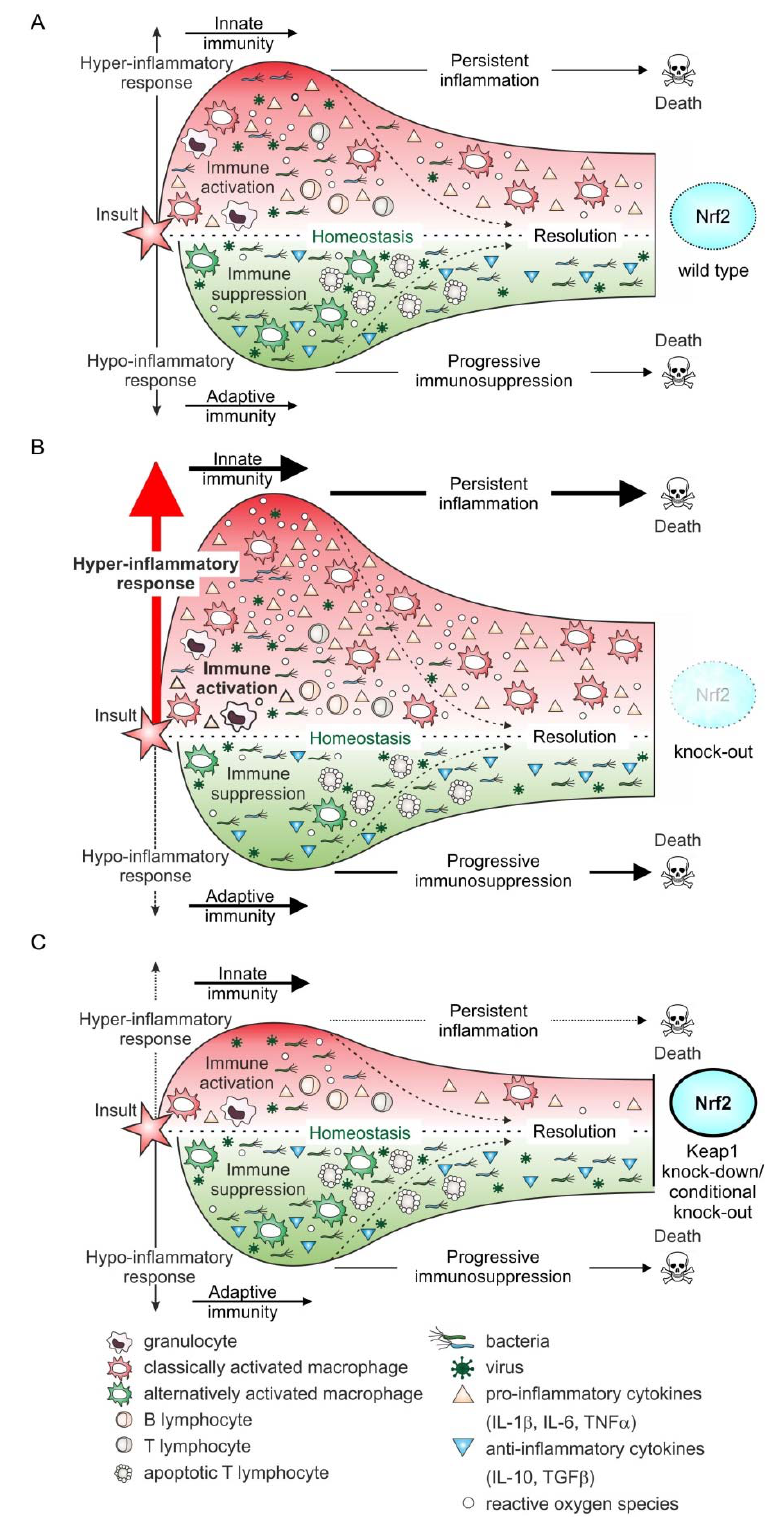
Figure 4. Nrf2 and the immune response during sepsis progression. In the Nrf2 wild type situation ( A ), the immune system is activated due to an initial insult. This leads to the activation of cells of the innate response, such as granulocytes and monocytes / macrophages. The latter are classically activated following bacterial or viral exposure, a process enhanced by IFN γ , released from recruited helper T lymphocytes (CD4 + ), which are adaptive immune cell. The adaptive immune response is characterized by excessive expression of pro-inflammatory cytokines and the massive release of reactive oxygen species [92,93]. During sepsis’ development and progression, this phase can persist, conferring permanent